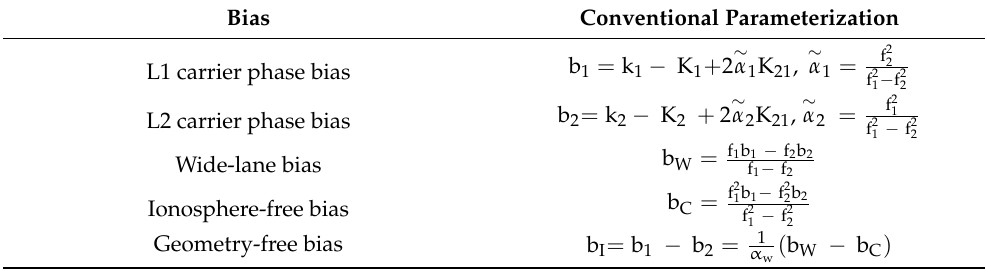
Table 1. A summary of the carrier phase biases in PPP models associated with the conventional clock parameterization